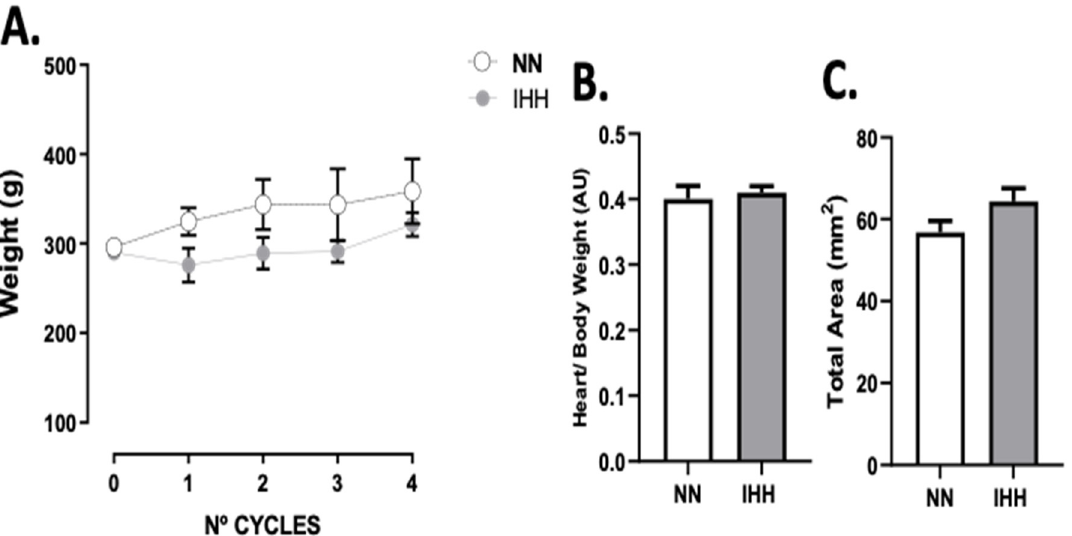
Figure 1. Body and heart weight. The animals’ body weight was measured at the beginning of each experimental cycle ( A ). In addition, heart/body weight ( B ) was measured at euthanasia., total area ( C ) are shown. Groups are normobaric normoxia (NN, n = 6) and intermittent hypobaric hypoxia (IHH, n = 6). Data are expressed in mean ±